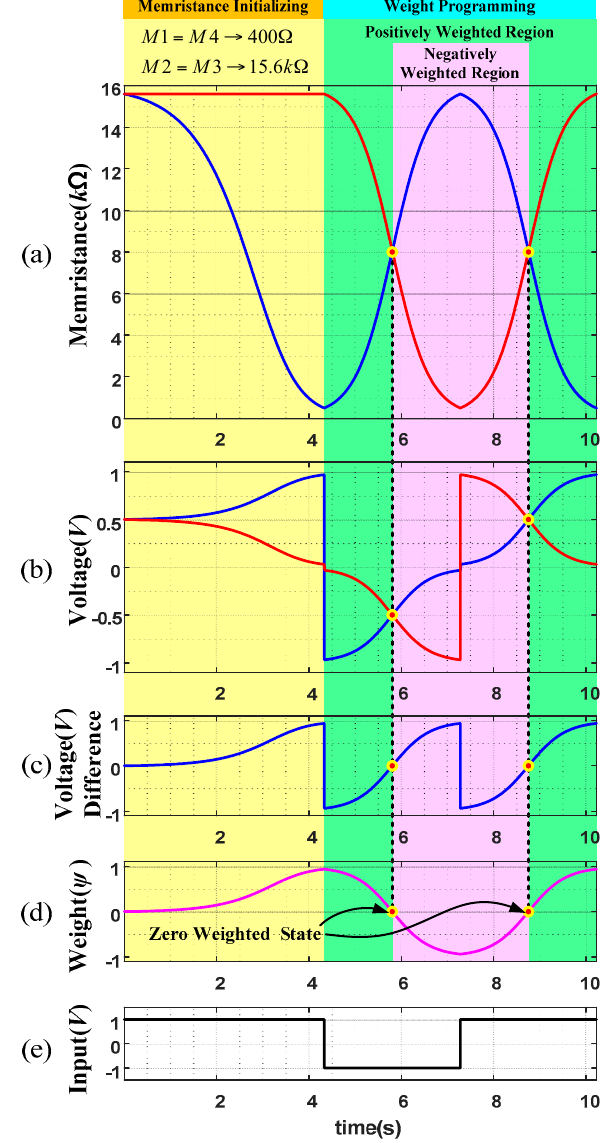
Figure 13. Linearized programming of the memristor bridge synapse which is composed of two different types of anti-serial non-linear memristors. ( a ) variation of memristances; ( b ) changes of voltages Vp and Vn ; ( c ) difference of middle voltage ( Vp − Vn ); ( d ) weight changes of the memristor bridge synapses; and, ( e ) wide pulse for programming.